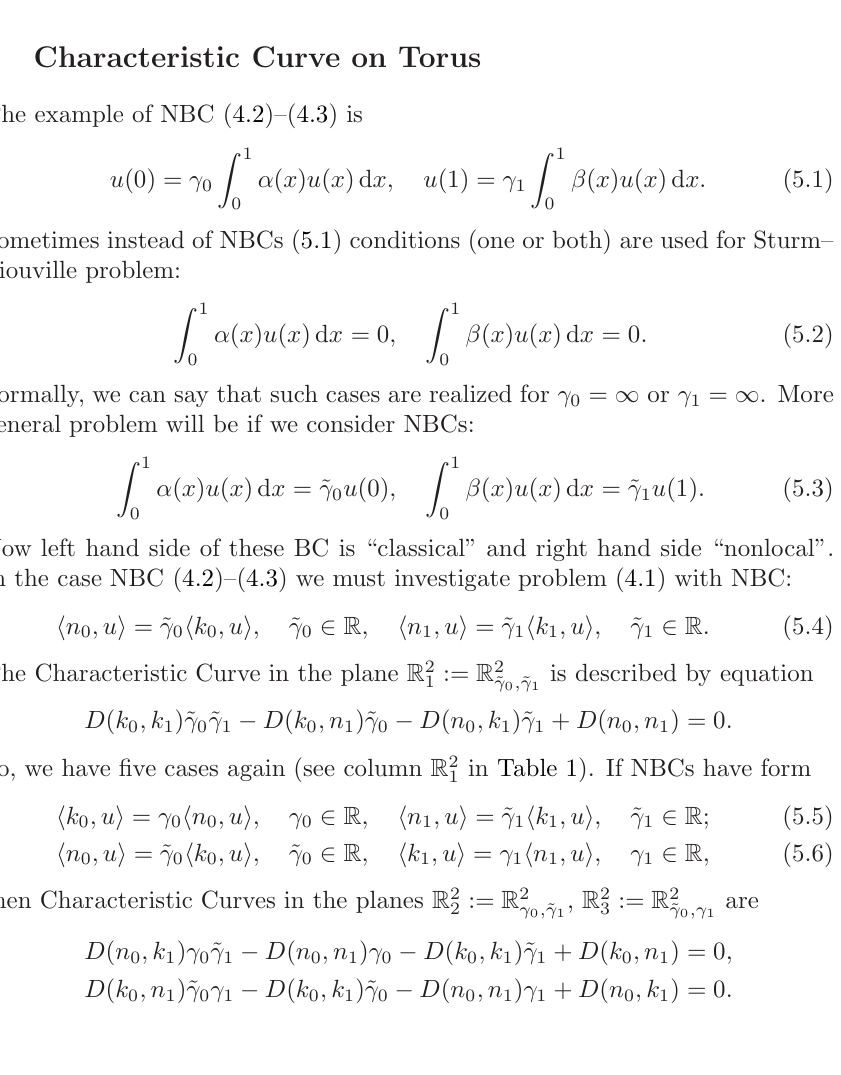
Figure 3. Plane, cylinder and torus, O = (0 , 0), X = ( ∞ , 0), Y = (0 , ∞ ), B = ( ∞ , ∞ ), in the plane ˆ R 2